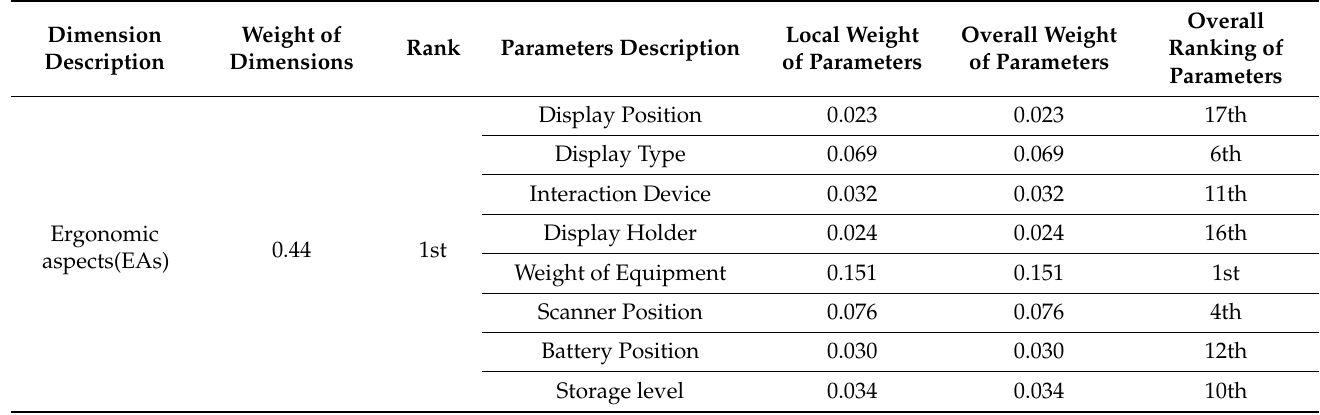
Table 4. Overall weighting and ranking of pick-by-vision design and development